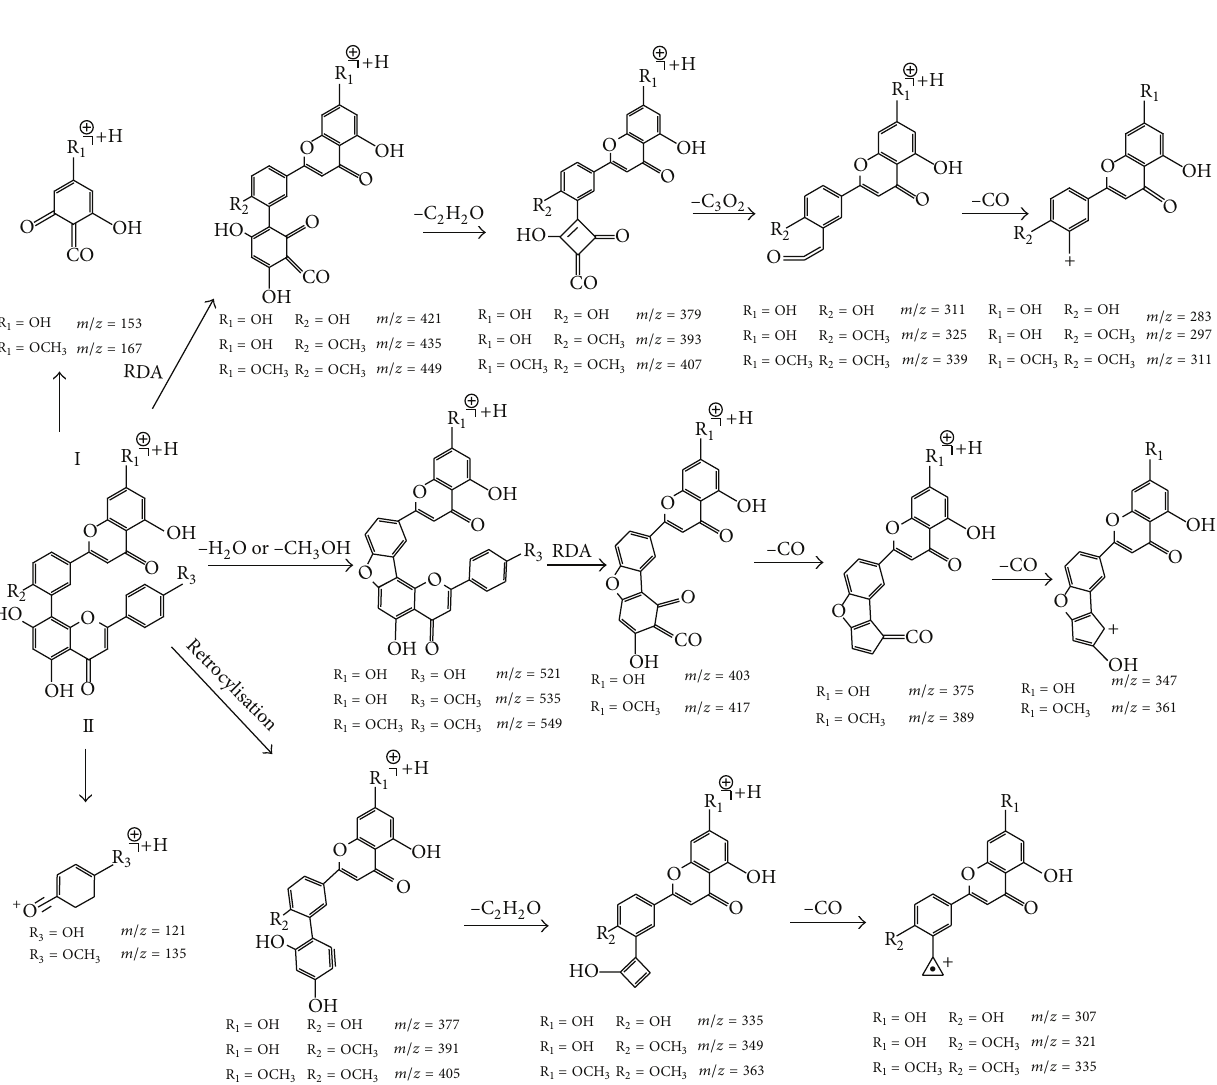
at 𝑚/𝑧 387. Getting involved with the cleavage at position 1/4 of the C-ring on flavonoid part I, the other significant pathway arouses the [M+H-C 6 H 4 O 3 ] + at 𝑚/𝑧 413. What is more, we noted one special electronion at 𝑚/𝑧 270. It displays a cleavage as a connection of the two flavonoid parts.